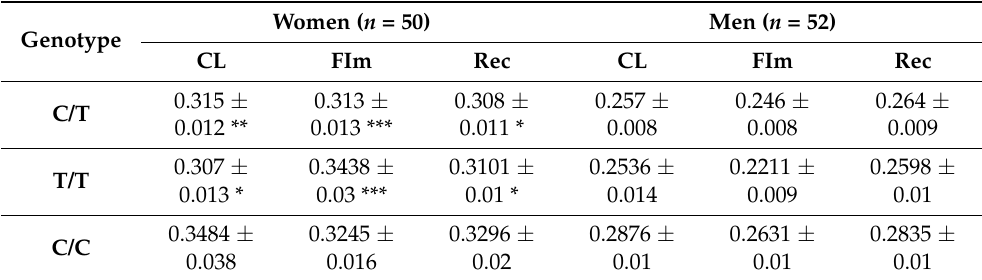
Table 5. Difference in rheographic index (RI, Ohm) between men and women with matched ADRA1A p.Arg347Cys (rs1048101) genotypes.